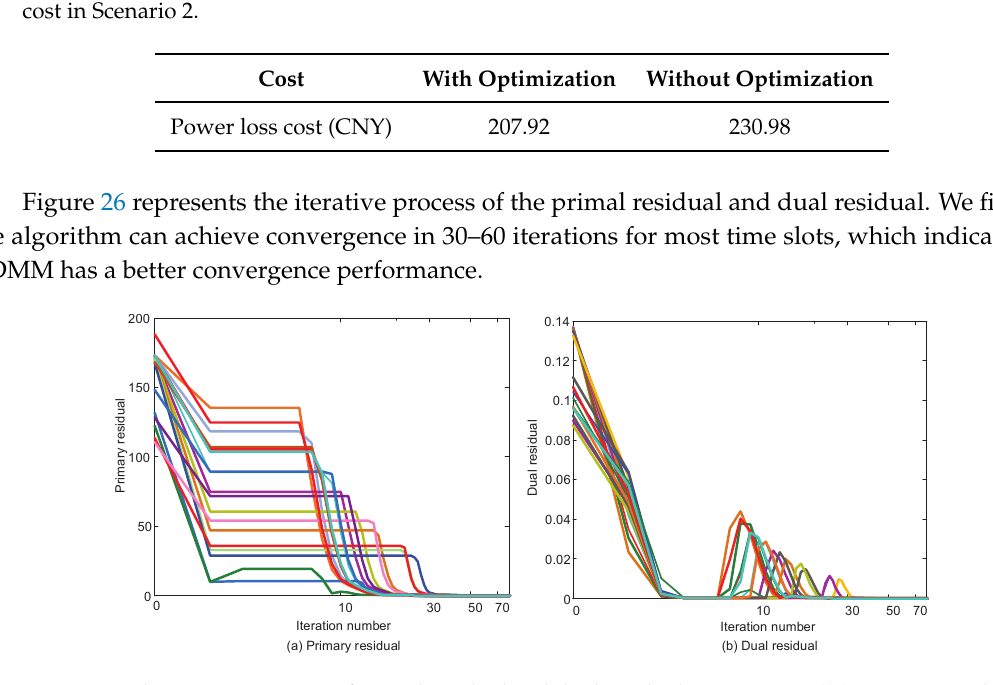
Figure 26. The iterative process of primal residual and dual residual in Scenario 2 (( a ) Primary residual; ( b ) Dual